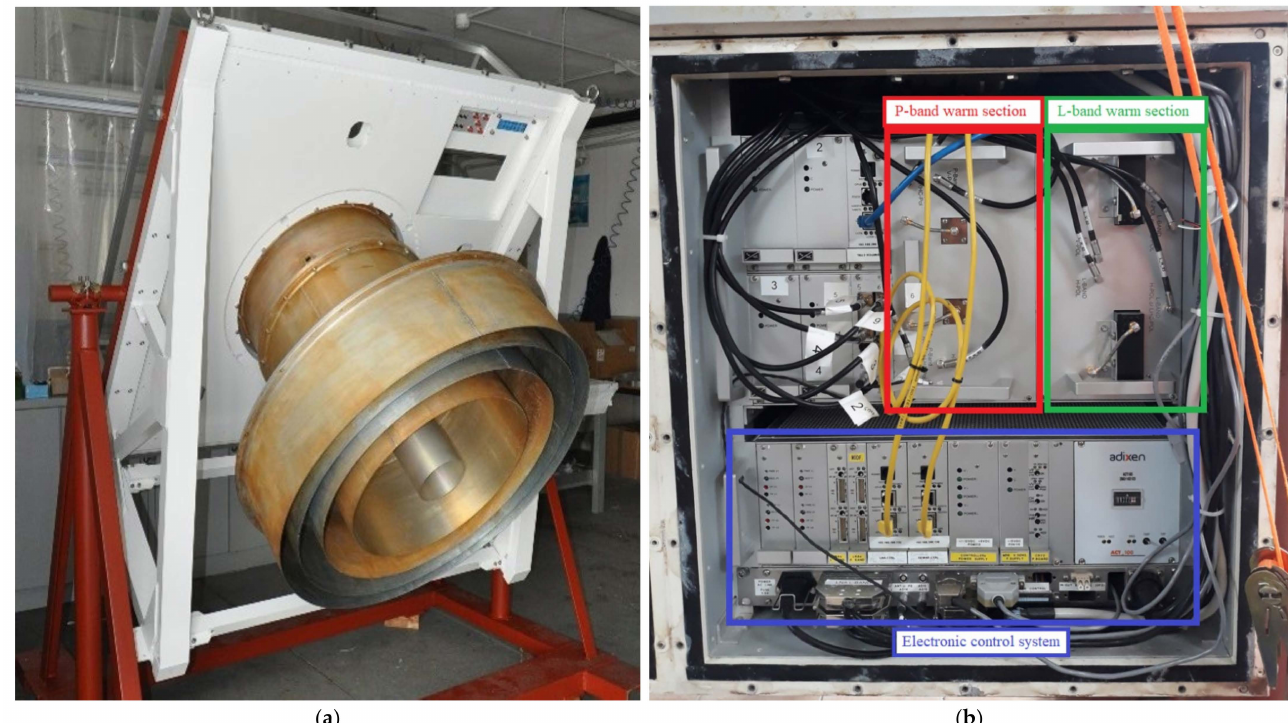
Figure 4. ( a ) Photo of the feed; ( b ) Photo of the warm section (which works at the temperature of 300 K) of the receiver, composed of the linear-to-circular polarizer, the filter selector block and the electronic control